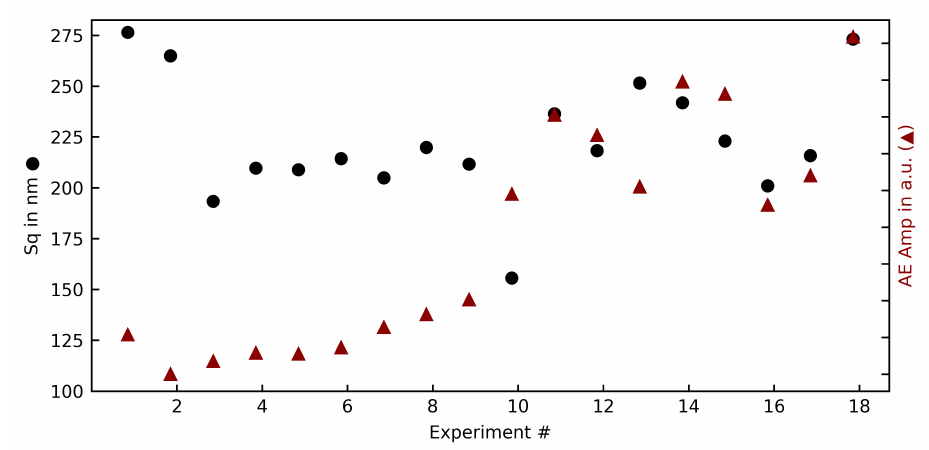
Figure 9. The AE amplitude in a.u. (average over 1 s) in relation to the quadratic surface roughness Sq. A recovered chip is shown in Figure 10. To verify that it is indeed a SiC chip, an EDS analysis was undertaken. At an acceleration voltage of 5 kV, the EDS shows only silicon (atomic concentration 23.6%) and carbon (atomic concentration 76.4%). The higher carbon content can be explained by the relatively low vacuum strength of the used SEM, thus having a surplus of atmosphere inside.